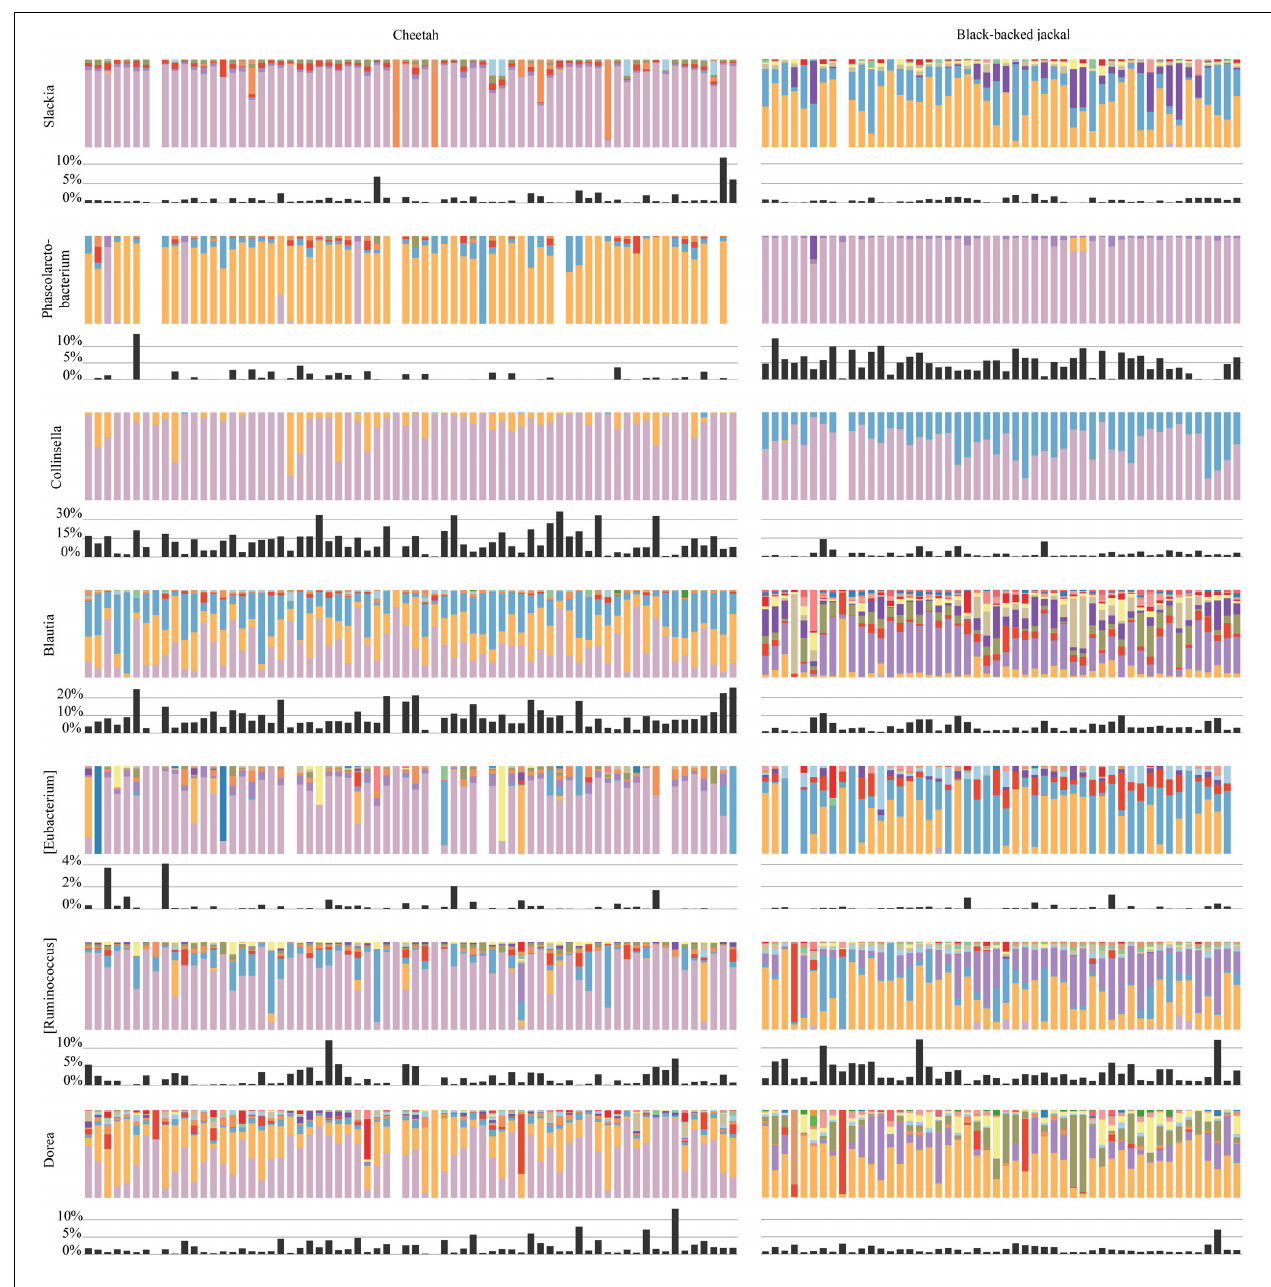
FIGURE 6 | Oligotype profiles for each cheetah and black-backed jackal individual for shared bacterial taxa which were ≥ 75% dissimilar in the species level comparison. Lactobacillus , Megamonas , and Parabacteroides are excluded from this analysis due to the limited number of host individuals which contributed to